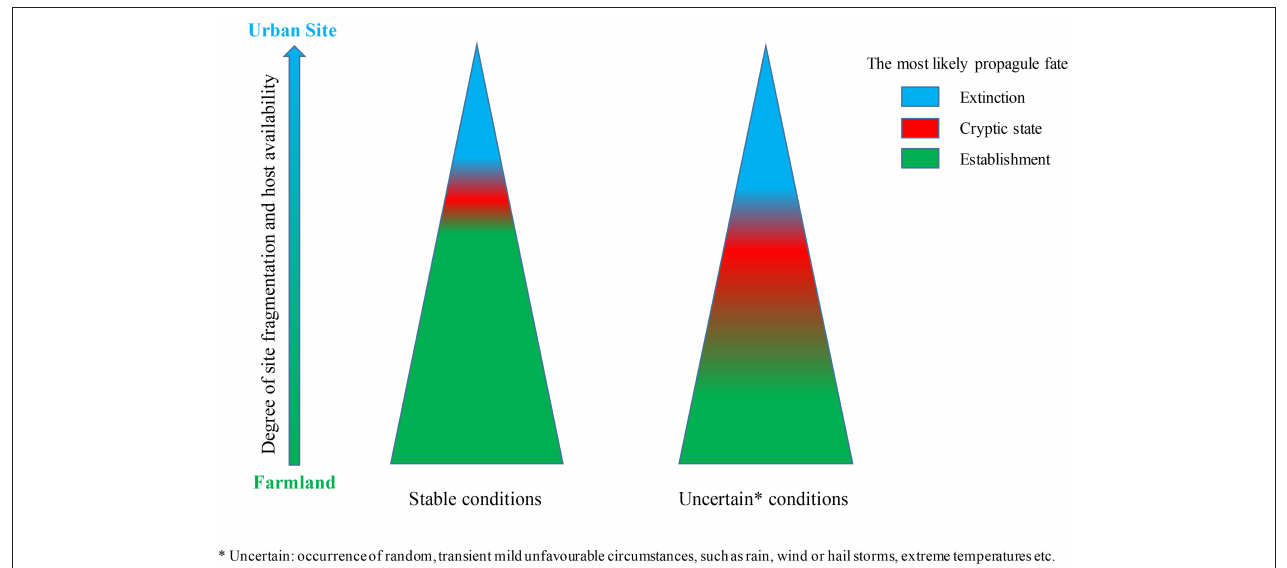
FIGURE 9 | Occurrence of medfly “cryptic” phase under periodically suboptimal conditions of varying